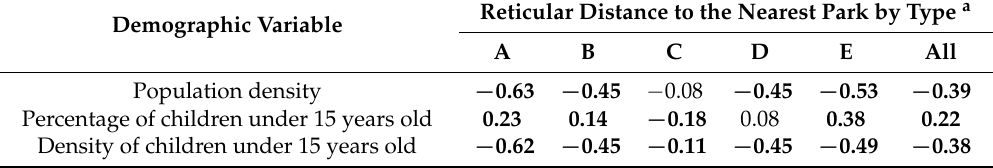
Table 5. Spearman’s correlations between network distance to nearest park and demographic variables, by ward.